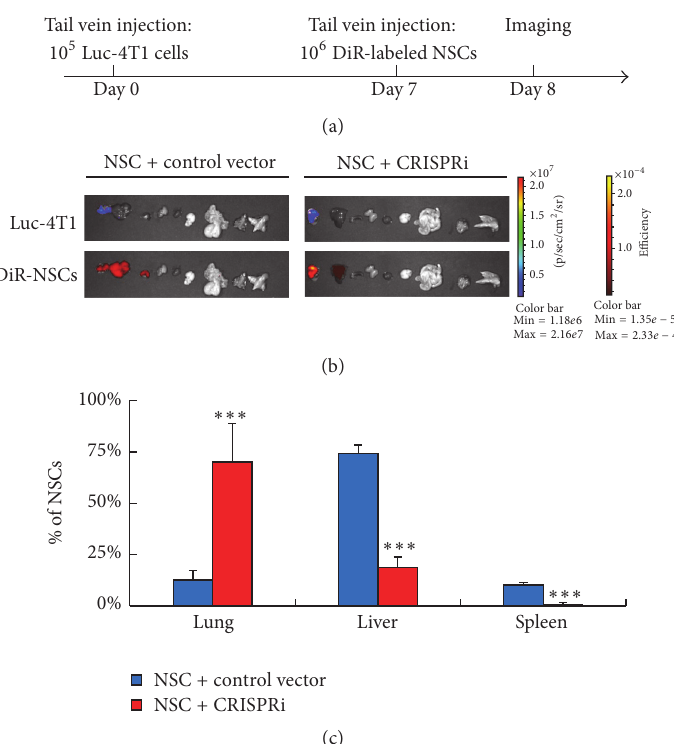
Figure 4: Inhibition of the miR-199a/214 cluster enhances NSC tumor tropism in vivo. (a) Diagram showing the protocol of NSC in vivo tumor tropism assay. (b) Representative ex vivo organs images showing the tumor tropism of NSCs in mice at day 8. The luminescent images (upper panels) show luc-4T1 tumor metastases in the lung. The fluorescent images (lower panels) show the organ distribution of NSCs. The organs shown in each panel from left to right: lung, liver, spleen, kidney, heart, brain, stomach, spinal cord, and femur. (c) Histogram showing the percentages of NSCs distributed in the lungs, the livers, and the spleens ( 𝑛 = 3 ). Error bars: SD. ∗∗∗ 𝑃 < 0.001